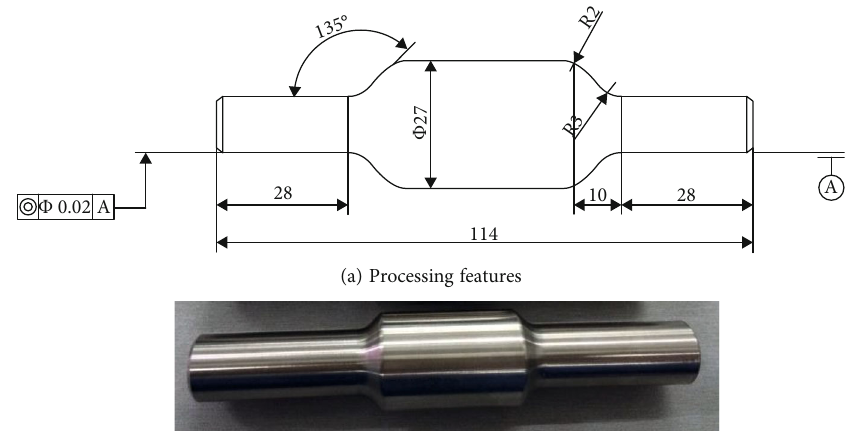
Figure 5: The machined workpiece.